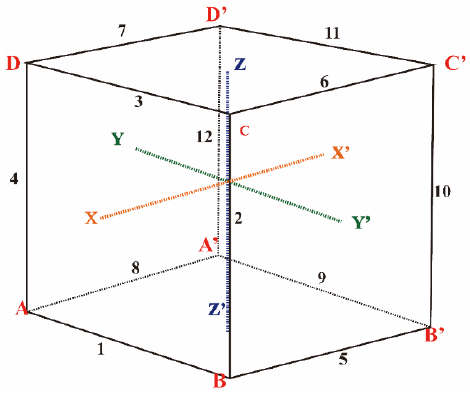
Figure 8. Boundaries of